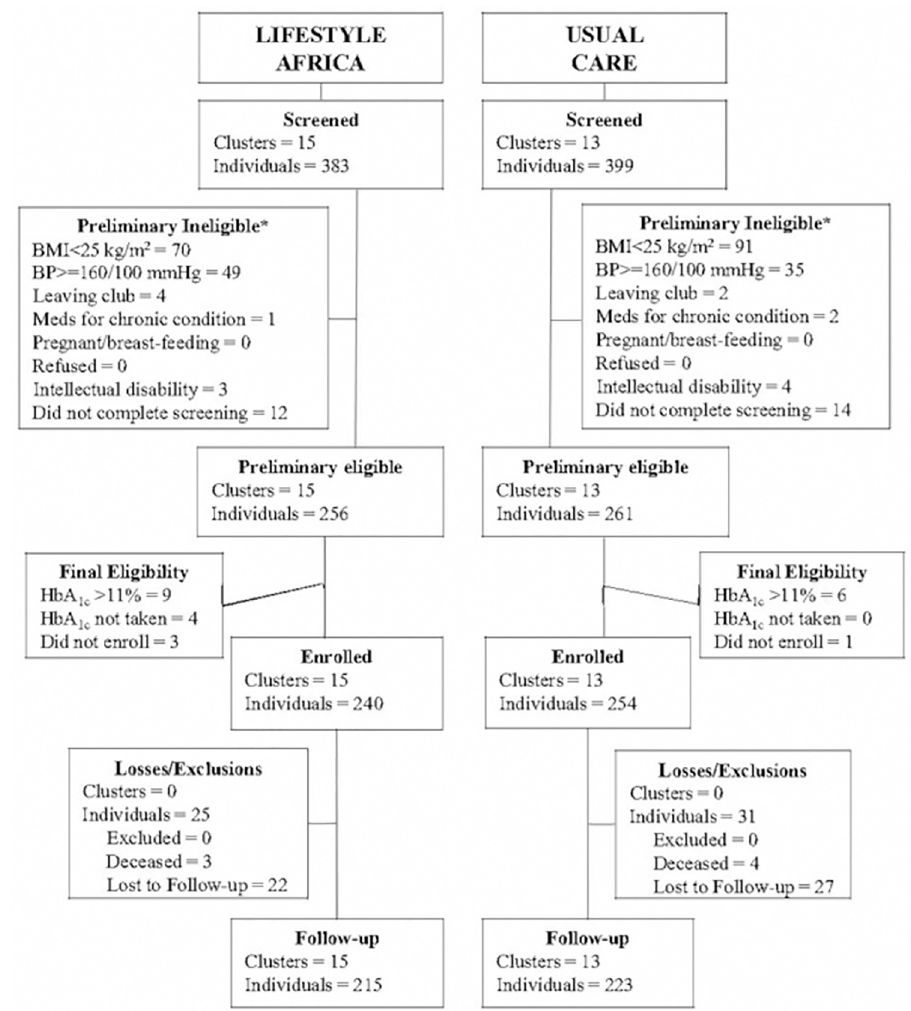
Fig 1. CONSORT flow diagram. � Participants could be ineligible for more than one reason. BMI, body mass index; BP, blood pressure; HbA1c, hemoglobin A1c; Meds, medications. respect to sex, males represented a higher proportion among those lost to follow-up than those who completed the study [24% versus 10%, respectively; F (1,464) = 4.25, p = 0.04]. The only notable difference within the usual care arm was with respect to sex, with a higher proportion of those lost to follow-up being males [19% versus 10%; F (1,464) = 2.45, p = 0.12]. The modal number of sessions held by CHWs across clubs was 17 (range of 10 to 17). Mean attendance across all sessions varied by cluster, ranging from 44% to 83%, with a mean of 61%. Across all clusters, 42% of participants attended at least 75% of the sessions held. Fidelity rat- ings based on observation of 74% of sessions indicated that mean completion rates of session facilitation elements (i.e., fully completed versus partially or not completed) for each club ran- ged from 62% to 95% (mean = 85.4%). Mean ratings on a 7-point Likert scale (1 = poor/never and 7 = excellent/always) of group facilitation skills, MI skills, and overall performance were 5.5 (range = 4.9 to 6.3), 5.4 (range = 4.7 to 6.2), and 5.5 (range = 4.7 to 6.3), respectively. There were no unanticipated problems and serious adverse events were rare, unrelated to the inter- vention, and similar across groups (11 in Lifestyle Africa versus 13 in usual care).